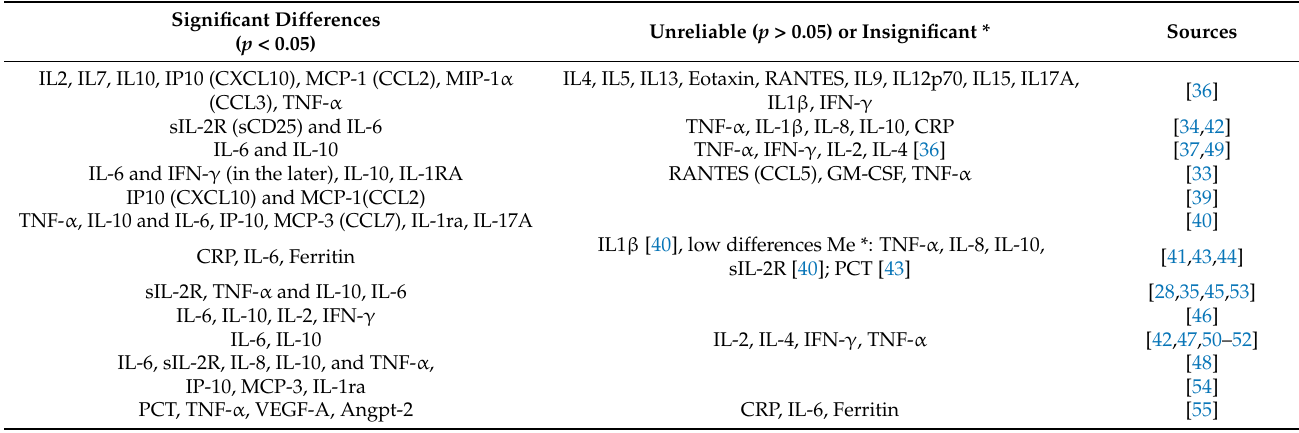
Table 1. Differences in the levels of cytokines and acute-phase proteins (ferritin and CRP) in patients receiving intensive therapy (higher concentrations) and with a milder course of COVID-19 (less high). Significant Differences ( p <